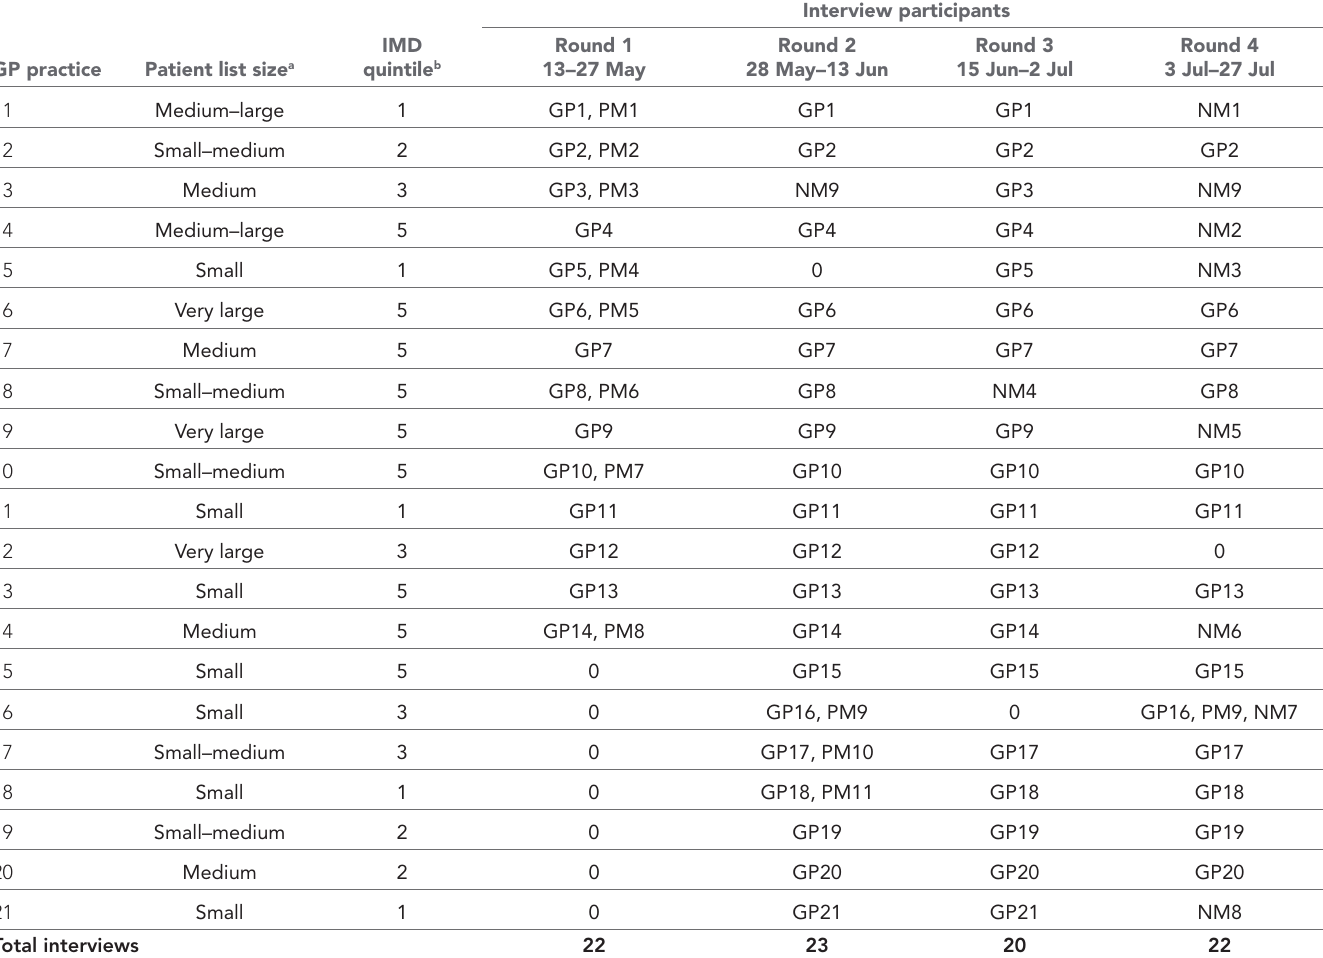
Table 1 GP practice and participant